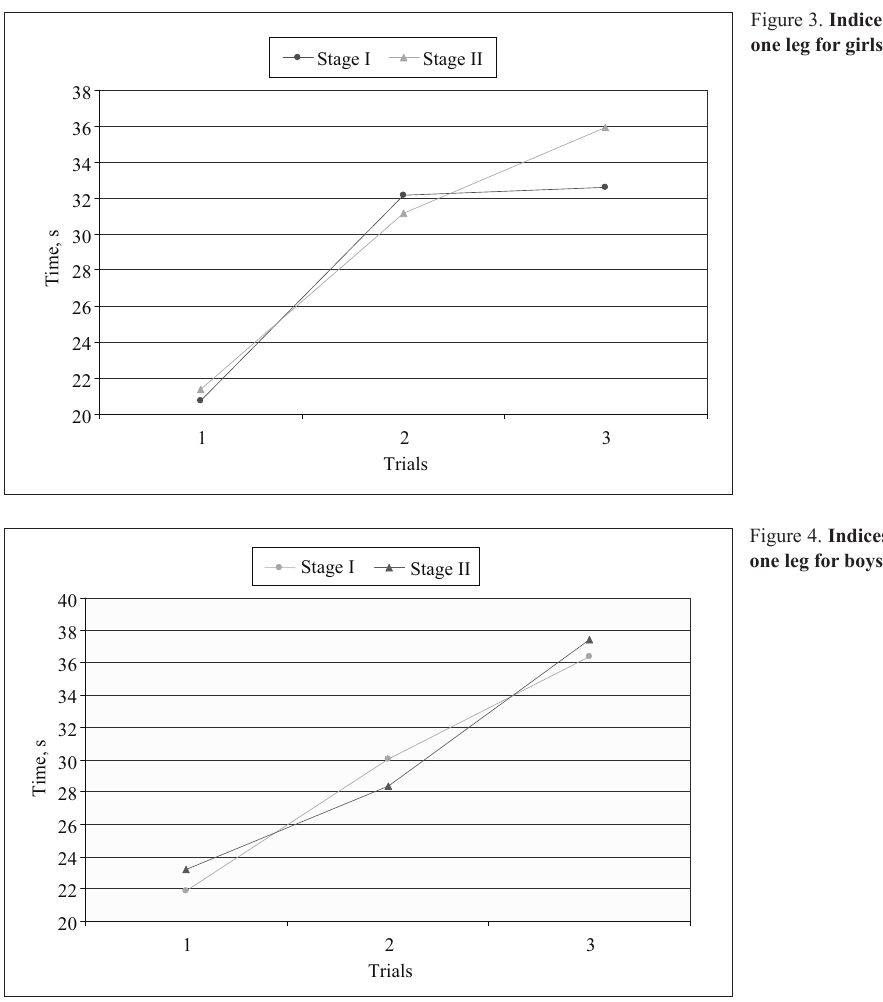
did not differ when the task was performed with the right or the left Figure 3. Indices of standing on the front foot of one leg for girls